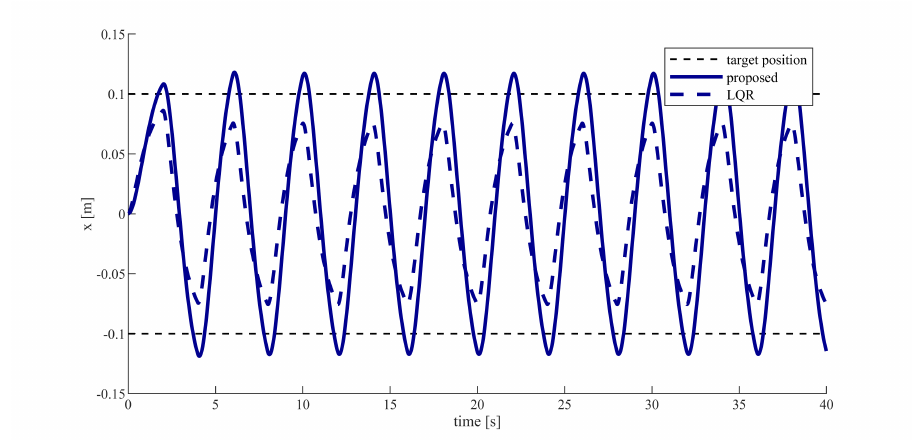
Figure 4. The end effector position value.